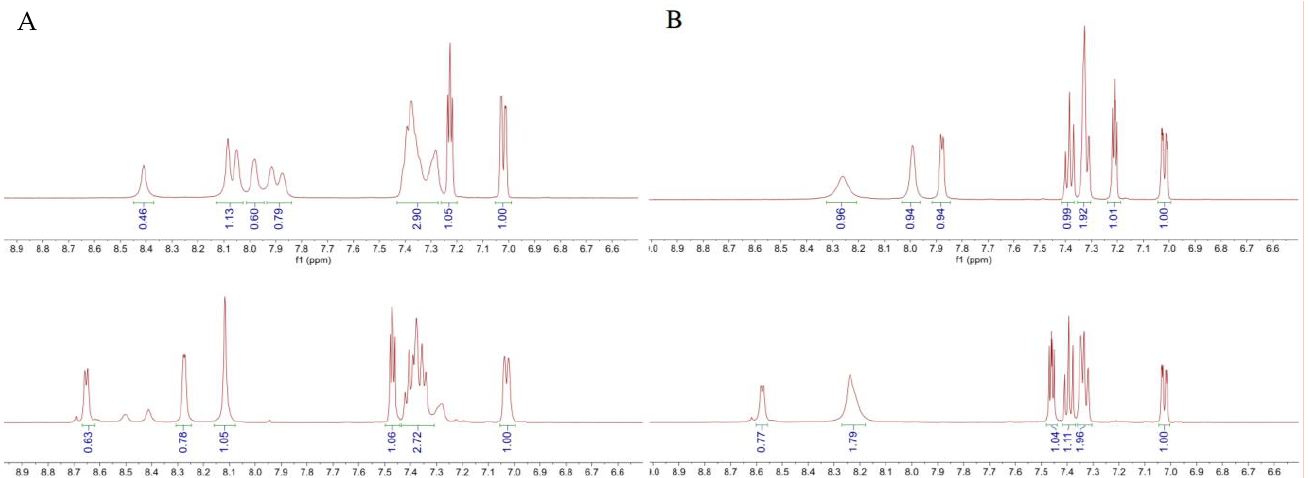
Figure 6. Comparison between spectra of compounds 11 and 12 at different temperatures and coalescence of doubled signals. ( A ) 1 H NMR spectra of 11 (top) and 12 (bottom) at 25 °C; ( B ) 1 H NMR of 11 (top) and 12 (bottom) at 80 °C.